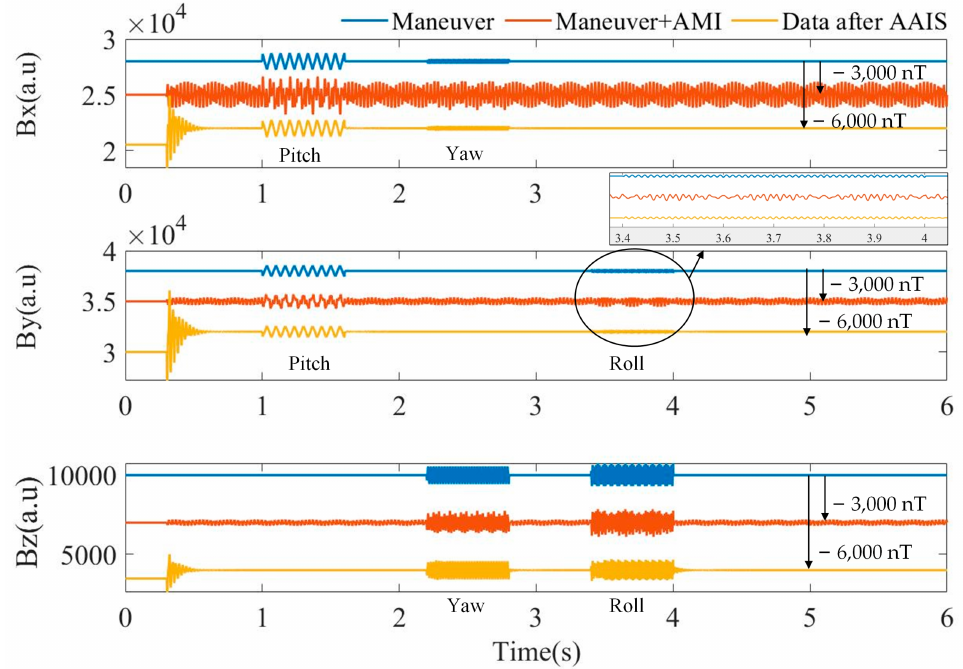
Figure 4. Simulation results. The components of a triaxial magnetometer in different situations. The blue curve shows the magnetic field change on each axis of the triaxial magnetometer, which is preset to simulate the plane maneuver. The orange curve shows the measurements of the triaxial magnetometer when AMIs exist. The yellow curve shows the data processed by